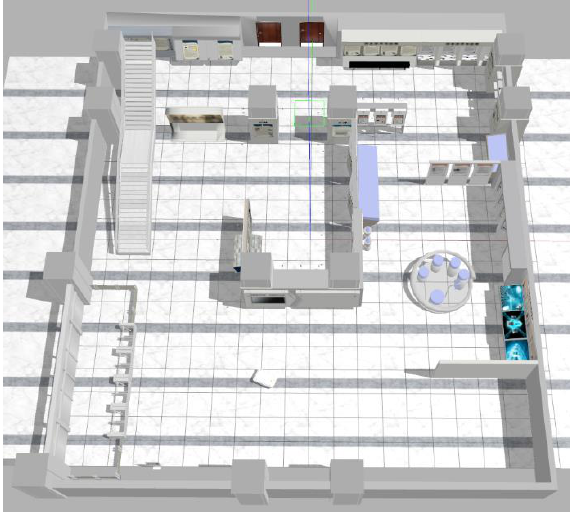
Figure 2. The Gazebo simulation environment.